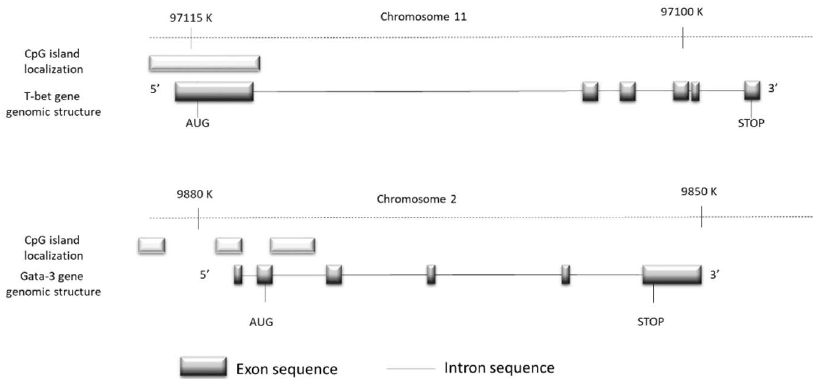
Figure 2. The representation of the promotor genomic regions of Tbet and Gata3 showing the localization of all CpG regions present into promotor regions of these transcription factors.